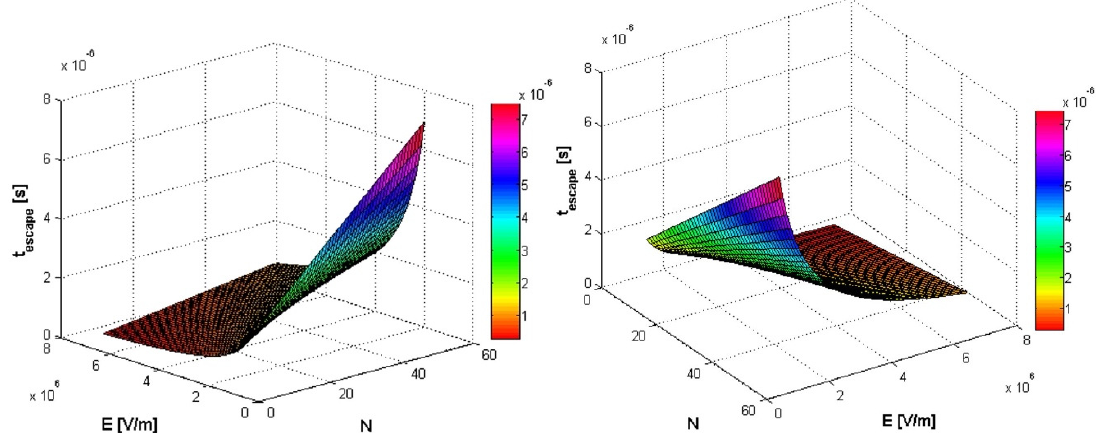
Figure 5. Simultaneous influence of both external electric field E (in the range [10 6 , 8 ∗ 10 6 ]) and monomers number N of polymer (in the range [1, 5]), on the translocation time.